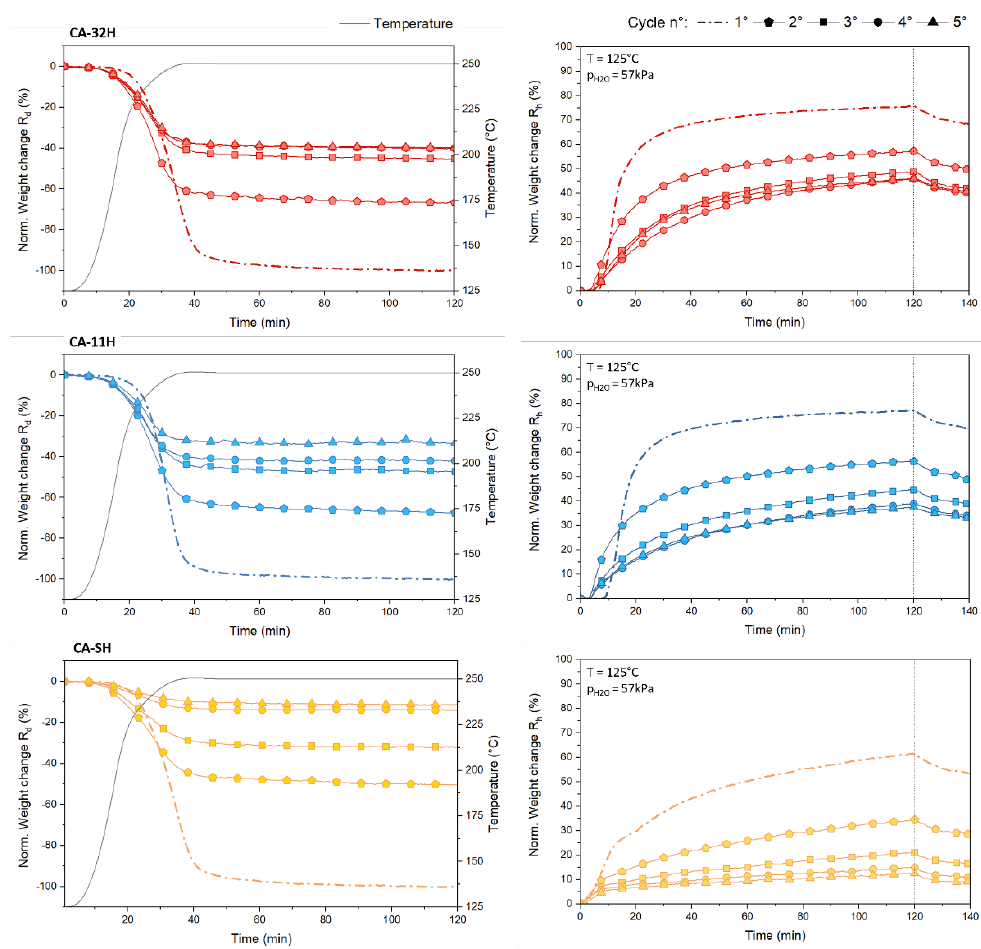
Figure 9. The 1st, 2nd, 3rd, 4th and 5th normalized dehydration/hydration curves for CA-32H (red), CA-11H (blue) and CA-SH (orange).